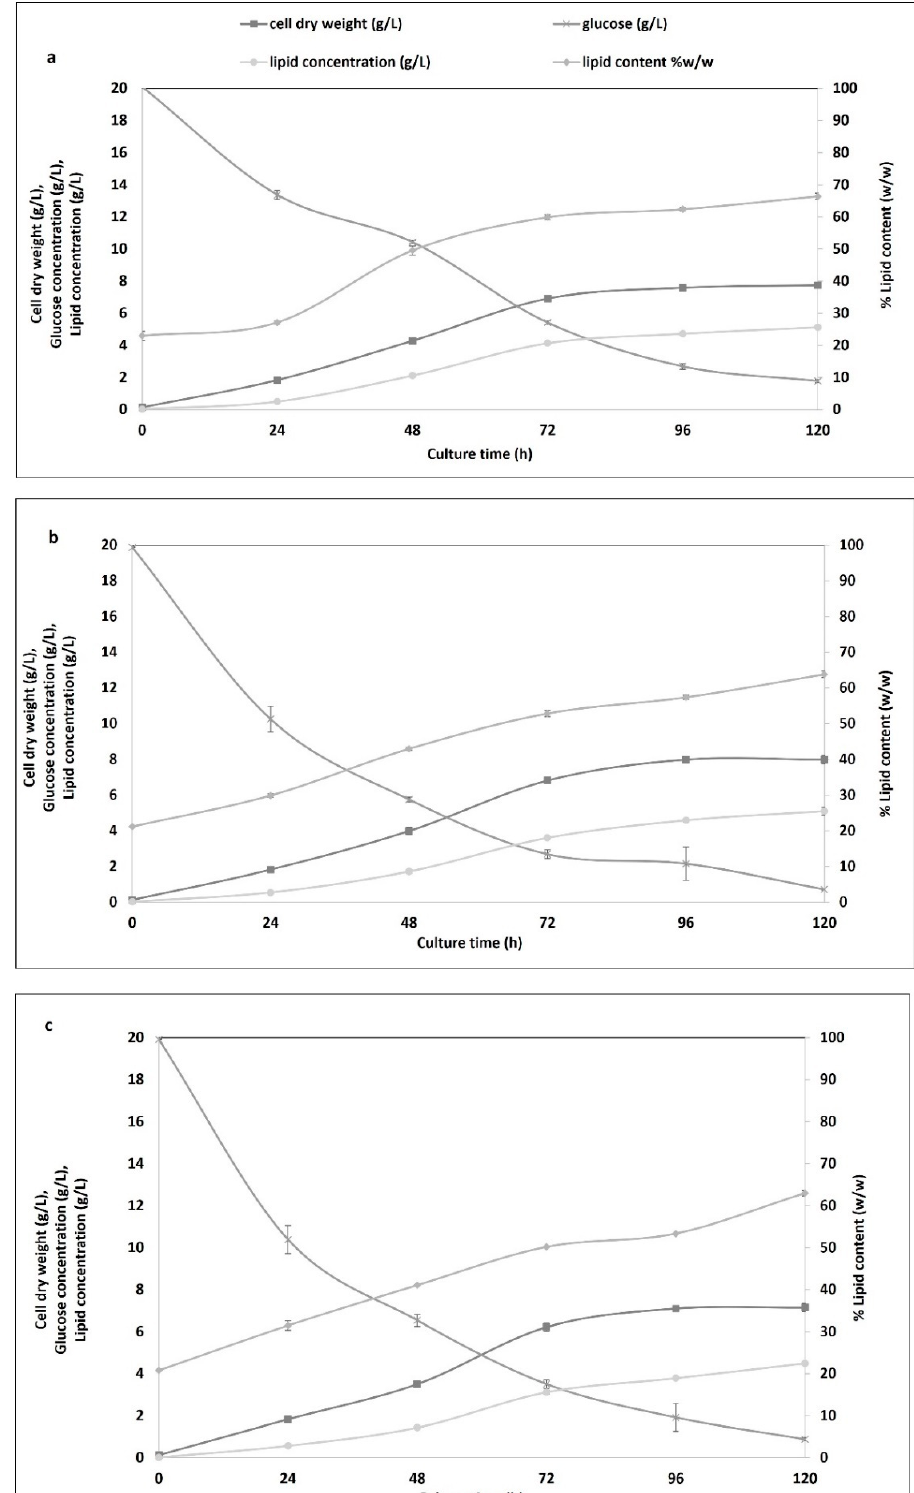
Figure 2. Time course showing batch cultivation of Pseudanabaena sp. in ( a ) glucose, ( b ) birch hydrolysate, and ( c ) spruce hydrolysate with 20 g/L glucose and C/N 40. All measurements were performed in duplicate and are represented as average values with standard